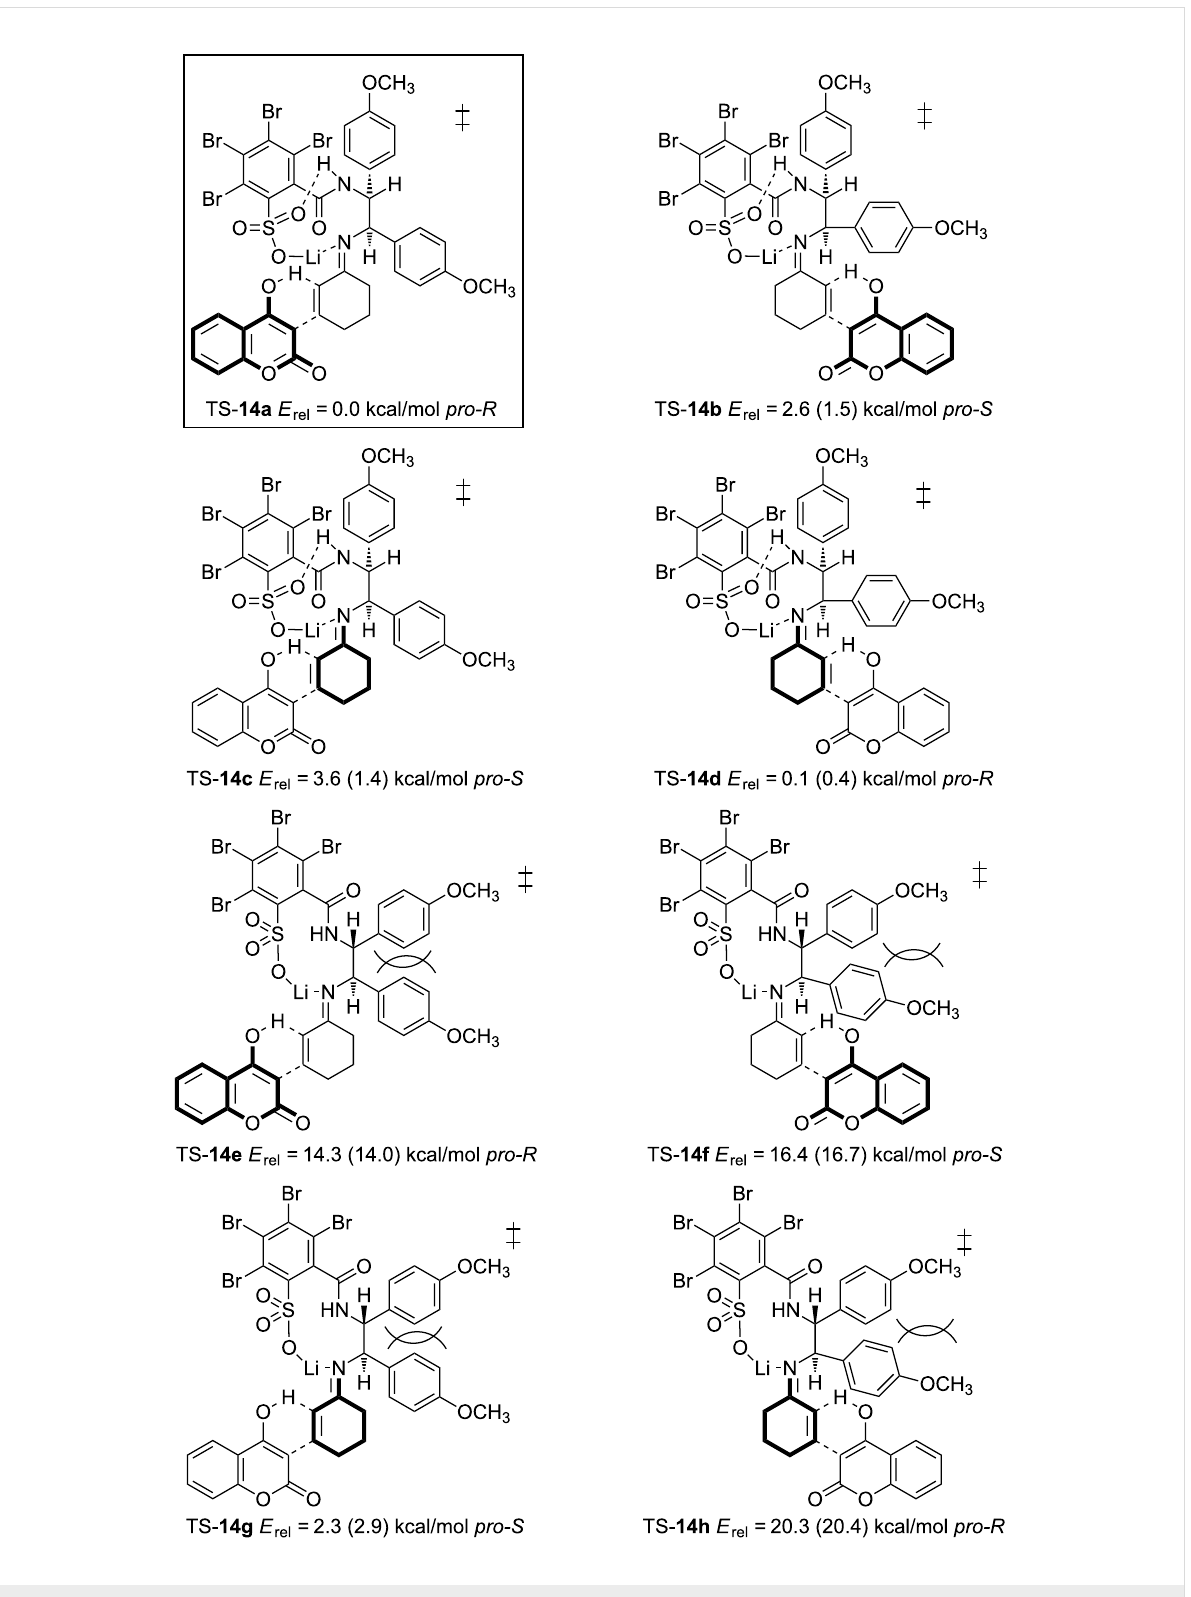
Figure 3: Enantio-determining transition states arising from the addition of 4-hydroxycoumarin to cyclohexenone employing 8 . Only transition states corresponding to TS- 14 (pathway A ) are shown, TPSS/SVP+ZPE